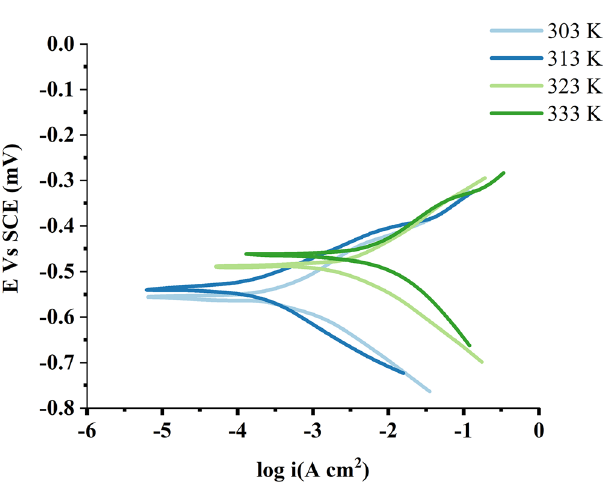
Figure 14. Potentiodynamic polarization curves for MS in 1.0 M HCl with 0.5 mM nonanedihydrazide at various temperatures.